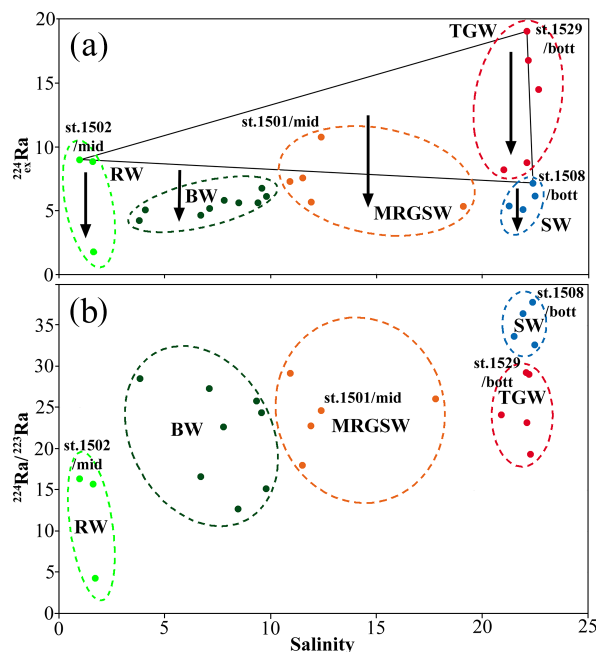
Figure 12. Salinity vs. 224 Ra (a) and 224 Ra / 223 Ra (b) in the win- ter. (a) The three main water-mass end-members are identified in this diagram: river water (RW – light green dots), seawater (SW – blue dots), and transformed groundwater (TGW – red dots), and two derivatives from the main water mass because of mixing: mixed river and seawater (BW – dark green dots), and mixed RW, GW, and SW (MRGSW – yellow dots). Black arrows are theoretical de- cay lines. (b) Similar to the mixing diagram panel (a) but using the 224 Ra / 223 Ra ratio. The straight line represents the theoretical mix- ing line derived from the major radium sources. Mid: middle of the water column, bott: bottom.